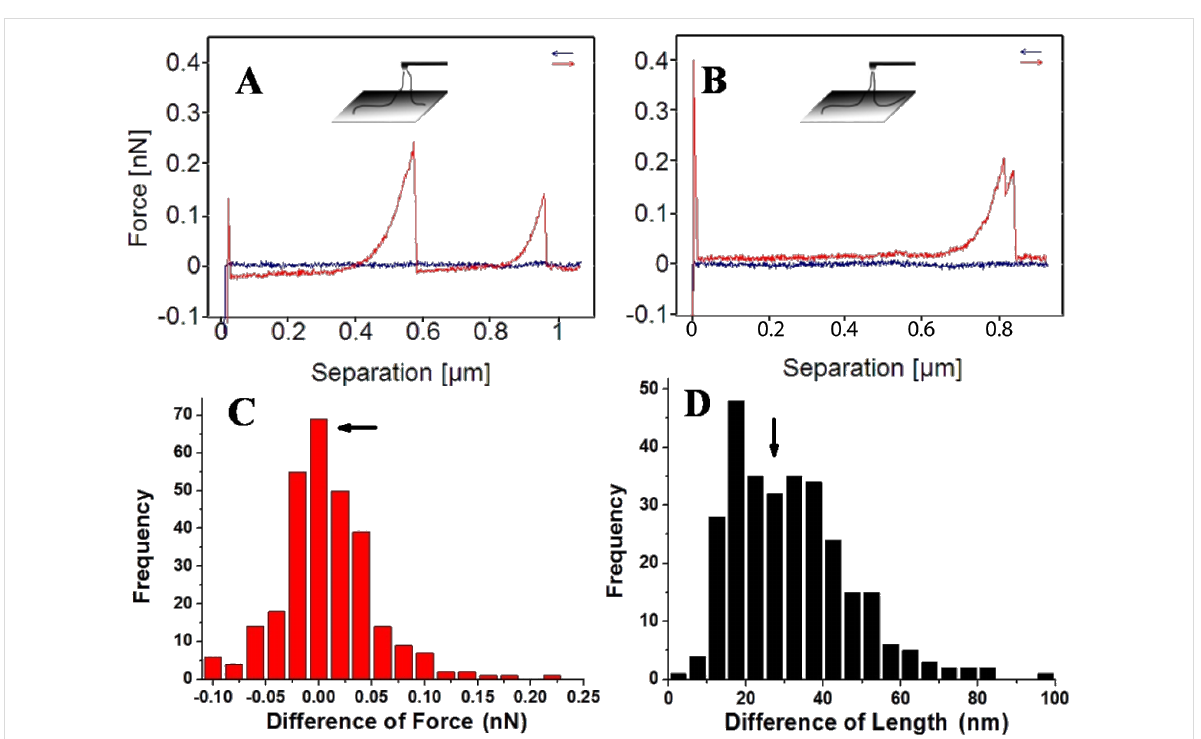
Figure 6: A) Typical double-peak force curve. B) “type 3” (t 3 ) force curve. C,D) histograms of the differences between the rupture forces and rupture lengths of the two continues peaks in t 3 force